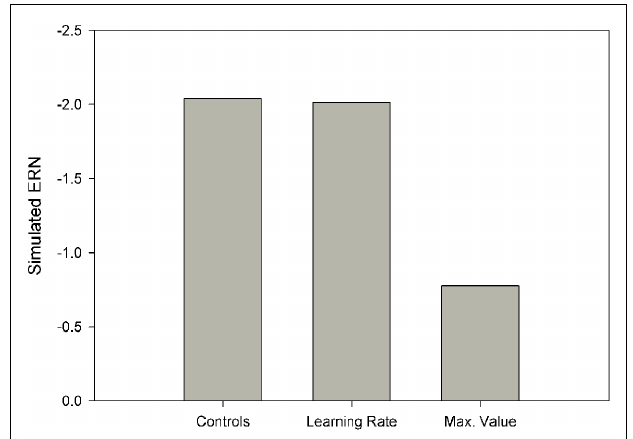
FIGURE 10 | Simulated response ERNs for the Eriksen flanker